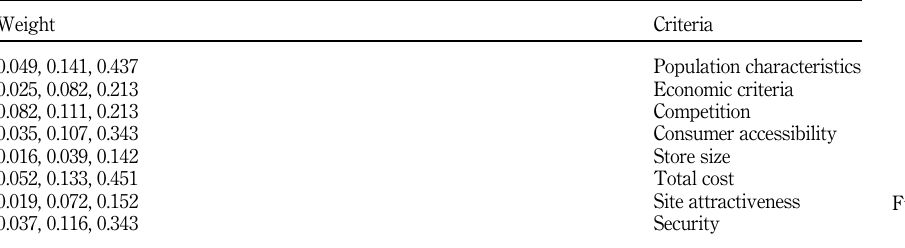
Table 3. Fuzzy weight matrix for